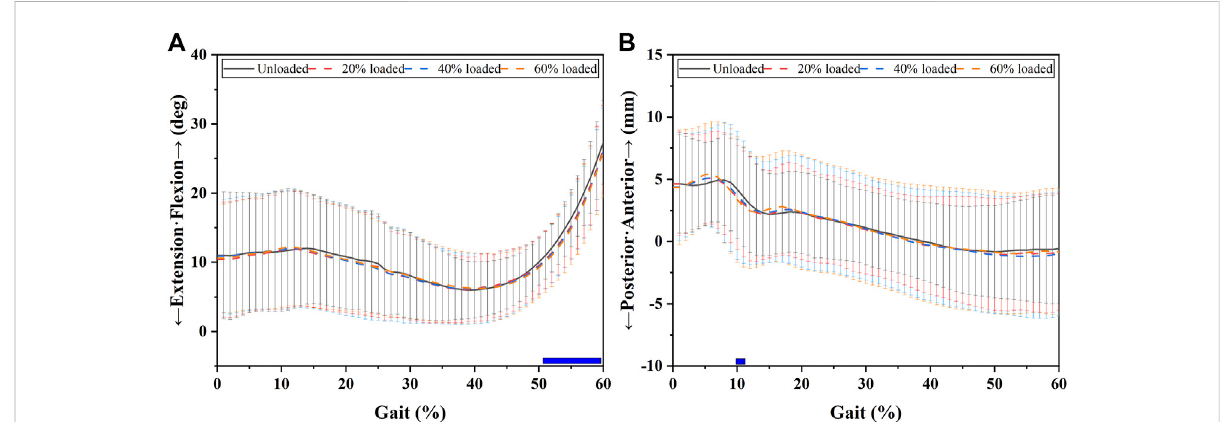
FIGURE 2 Sagittal knee kinematic alterations during the stance phase under increased load levels. Chart (A) shows the fl exion (+)/extension (-) alterations that occurred during the stance phase. Chart (B) shows the anterior (+)/posterior (-) tibial translation alterations that occurred during the stance phase. The blue bars in the charts show the phases in which the increased load levels signi fi cantly increased the extension angle or posterior tibial translation.